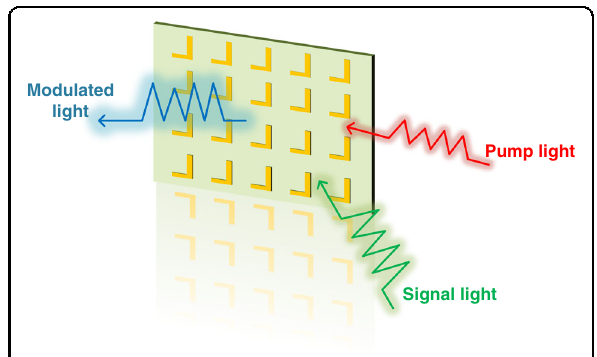
Fig. 1 Operation principle of all-optical modulation. Schematic of the all-optical modulation based on the